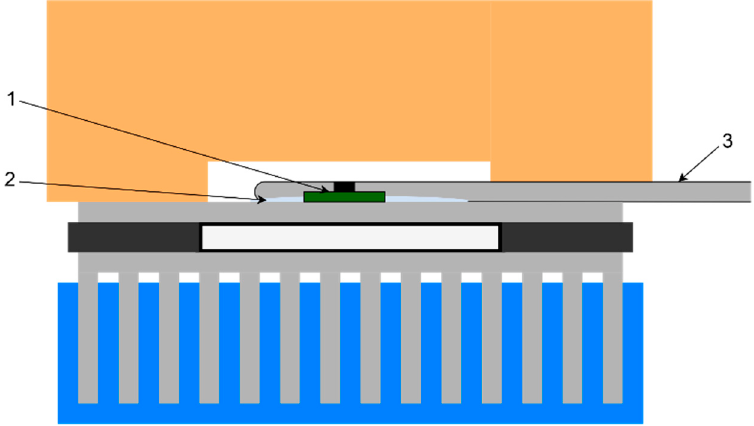
Figure 5. Test chamber setup for surface temperature calibration (1 − temperature sensor, 2 − thermal paste, 3 − Testo Pt100 probe).